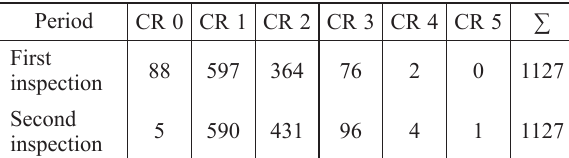
Table 1. Occurrence of events (condition ratings) at first and second inspection Period